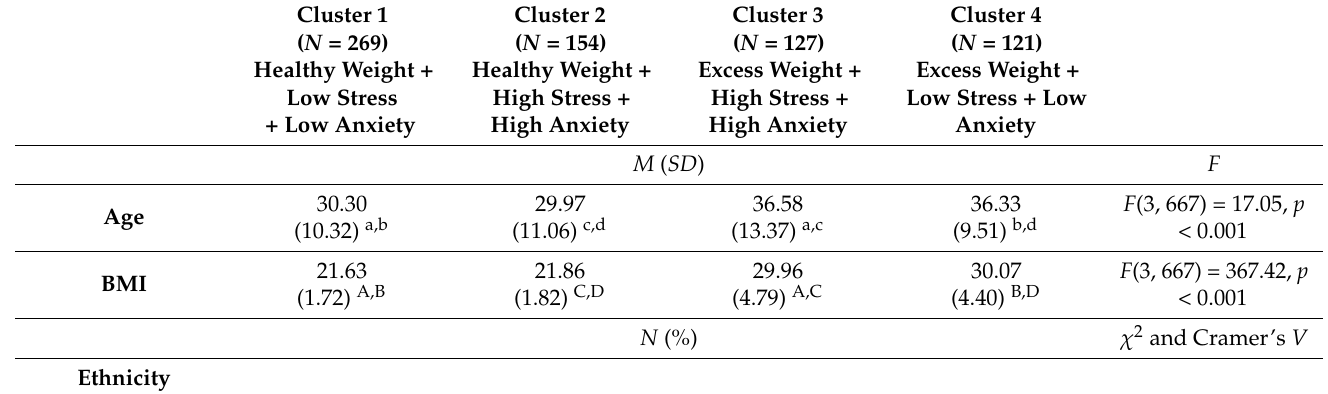
Table 1. Demographics characteristic of the four